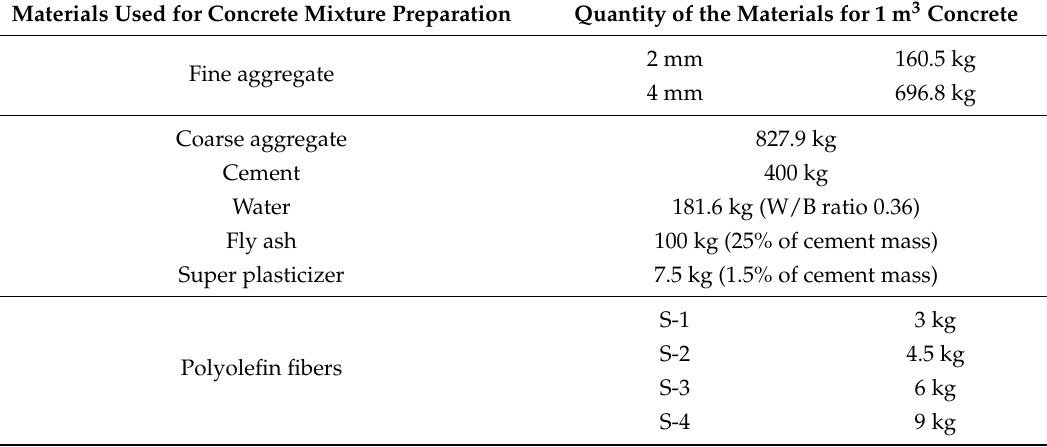
Table 1. Mixing proportions of concrete.